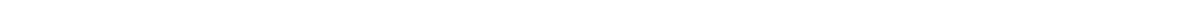
Fig. 5 The functional impacts of miR-327 on preadipocyte differentiation. a , b Assessment of adipocyte differentiation by Oil Red O and hematoxylin double staining of non-treated (NT)-, miR-NC-, miR-327-, Inh-miR-NC-, and Inh-miR-327-treated 3T3-L1 cells. Arrows indicate differentiated Oil Red O + adipocytes. c , d Quanti fi cation of differentiated Oil Red O + adipocytes as percentages of total adipocytes ( > 30 adipocytes per fi eld; n = 10 random fi elds). e , f Assessment and quanti fi cation of adipocyte differentiation by Oil Red O and hematoxylin double staining of undifferentiated (UD)-, non-treated (NT)-, miR-NC-, and miR-327-treated primary adipocytes derived from scWAT. Arrows indicate differentiated Oil Red O + adipocytes. Quanti fi cation of differentiated Oil Red O + adipocytes as percentages of total adipocytes ( > 30 adipocytes per fi eld; n = 10 random fi elds). g qPCR analysis of mRNA levels of Prdm16 , Pparg , Cebpa , Cebpb , Cebpg , and Adipoq in miR-NC undifferentiated (UD), miR-327 UD, miR-NC differentiated (Diff) and miR-327 Diff primary scWAT-SVF cells normalized to miR-NC Diff samples. Actb served as an internal control ( n = 5 samples per group). h qPCR analysis of mRNA levels of Ucp1 , Cidea , Ppargc1a , Cox7a , and Cox8b in miR-NC non-treated (NT), miR-327 NT, miR-NC isoproterenol (Isop)- and miR-327 Isop-treated primary adipocytes differentiated from scWAT-SVF cells. Samples were normalized using the miR-NC Isop group as a reference. Actb served as an internal control ( n = 5 samples per group). Scale bars, 100 μ m. NS, not signi fi cant. * P < 0.05, ** P < 0.01, and *** P < 0.001 by Student ’ s t -test. Data presented as mean ±